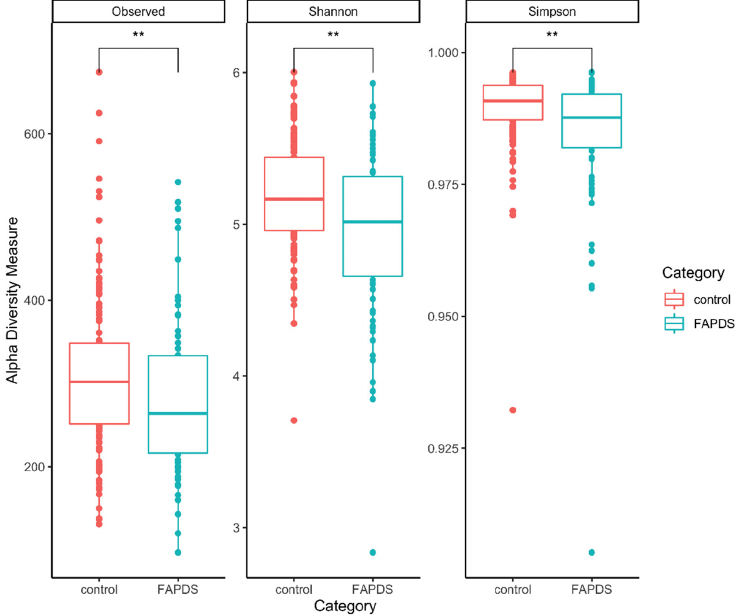
Figure 4. Alpha diversity comparison between the two groups. Shannon, Observed species, and Simpson were higher in the control group than the FAPDs group (Mann–Whitney, p < 0.05). ** denotes significance.